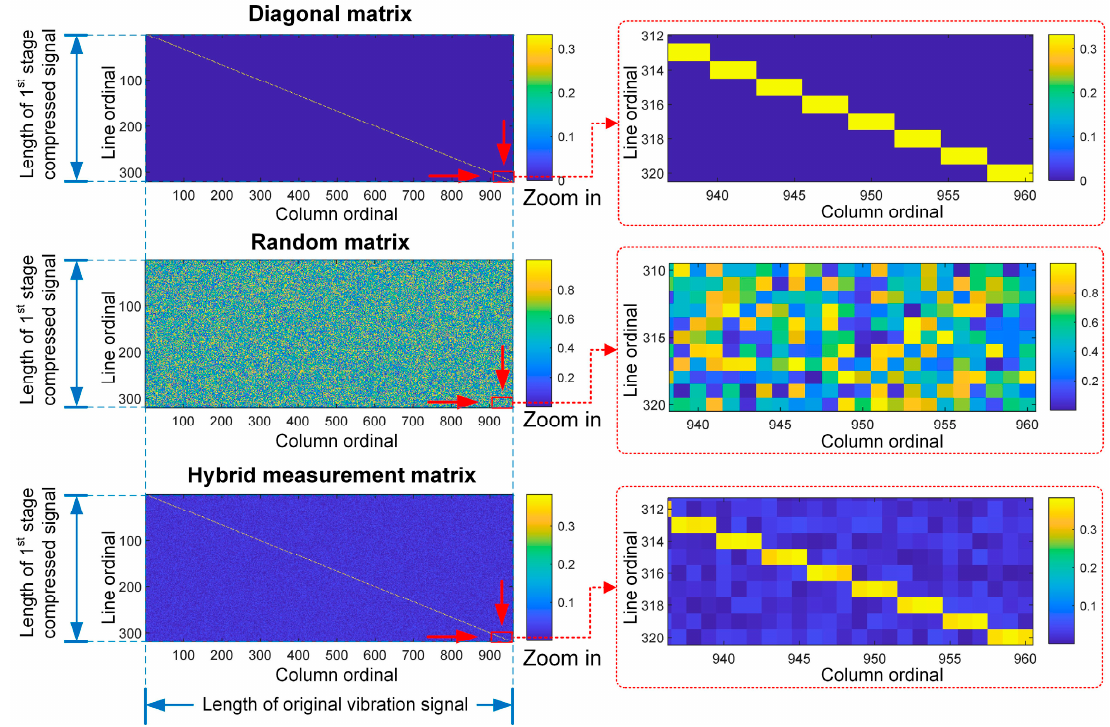
Figure 9. LGPG: Hybrid measurement matrix.